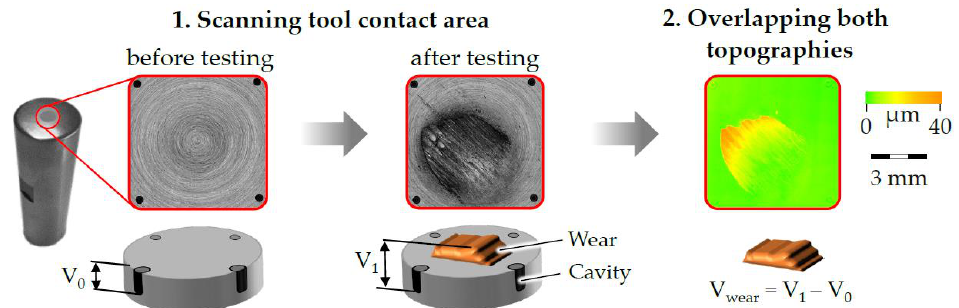
Figure 4. Process principle for analyzing the occurring amount of tool-sided wear.